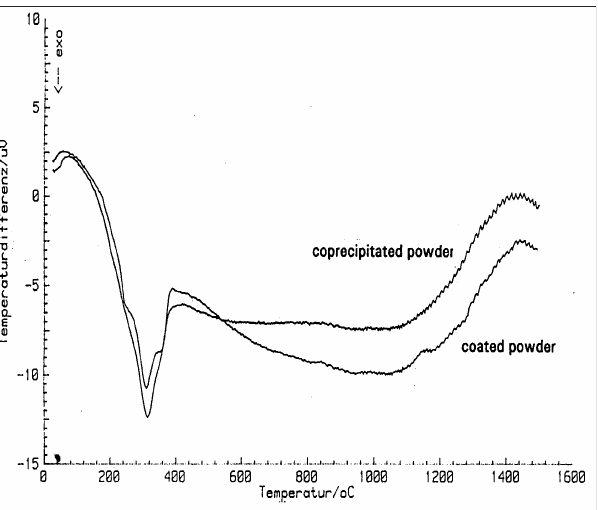
Figure 15. DTA-analysis of coprecipitated and coated yttria-zirconia composites.